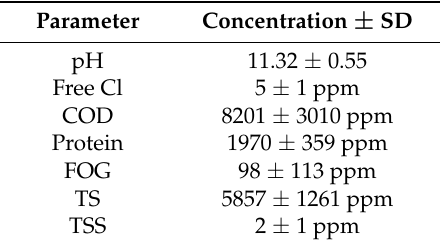
Table 4. Feed source